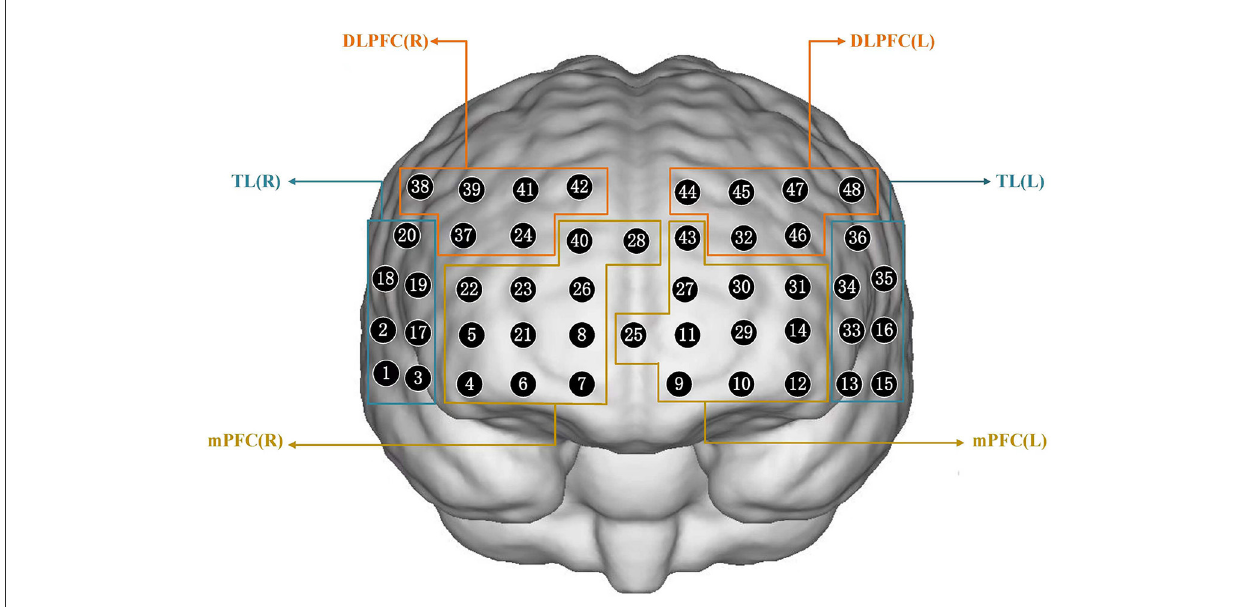
FIGURE2 Schematic of arranged fNIRS channels. DLPFC, dorsolateral prefrontal cortex; mPFC, medial prefrontal cortex; TL, temporal lobe; R, right; L, left.